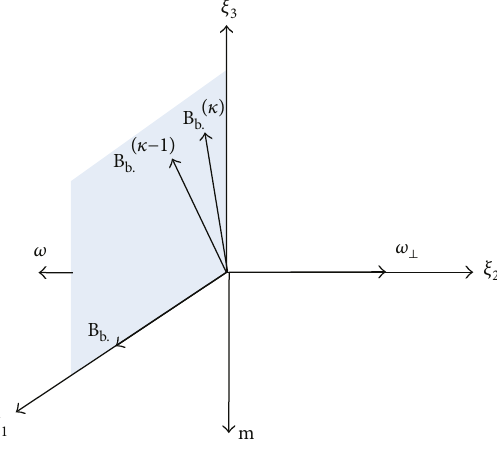
Figure 3: Rotation of B